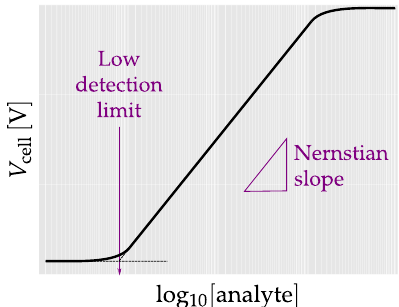
Figure 3. Schematic Ion-Selective electrode (ISE) static